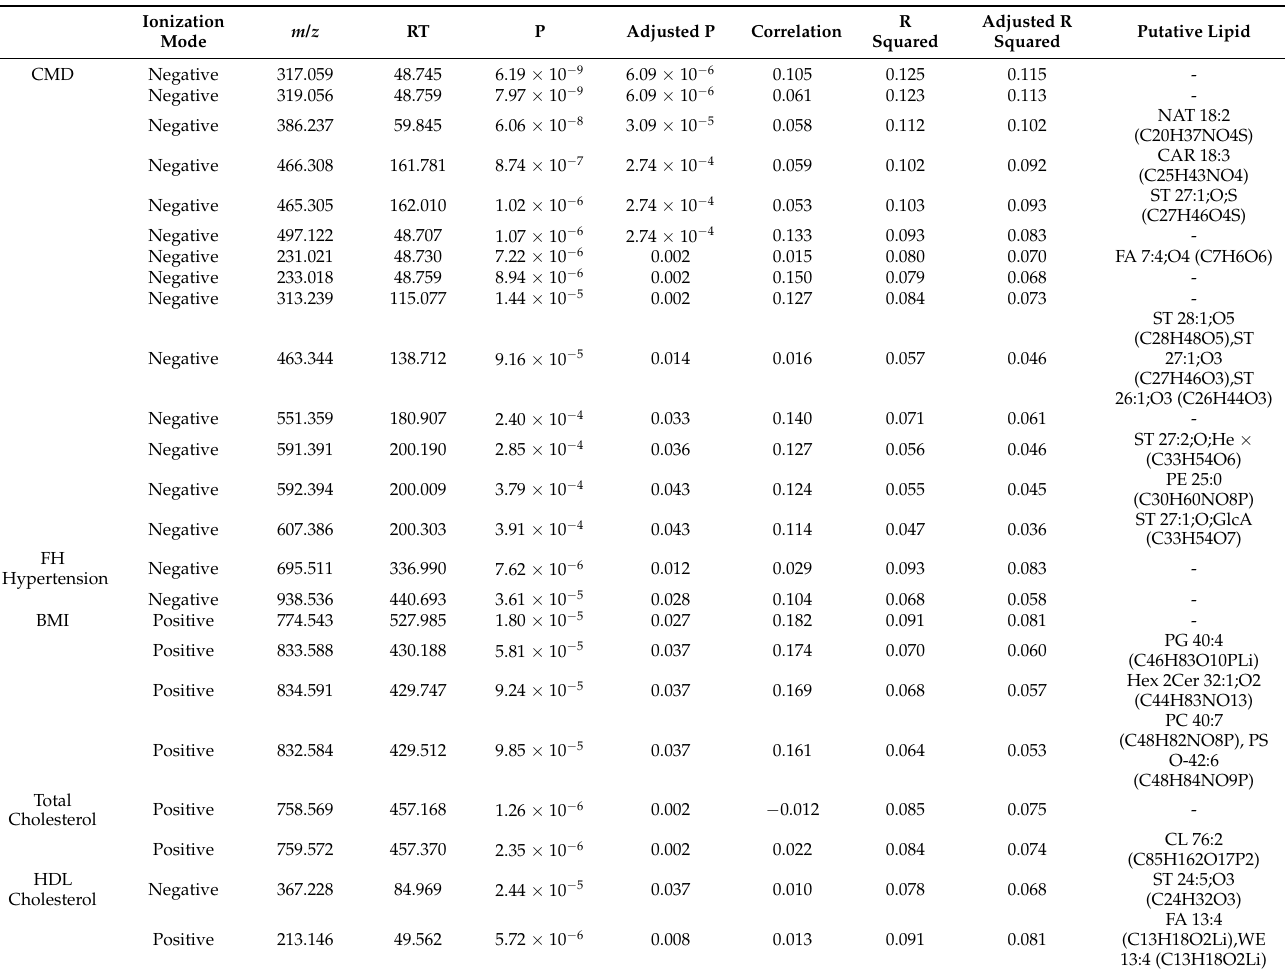
Table 4. Significant associations between lipidomic features and clinical and biochemical phenotypes in the study group. Lipidomic features were independently acquired in negative- and positive- ionization modes in serum samples from a study group of 273 individuals. Linear regression was used to compute a P-value statistic for each metabolic feature, which was corrected for multiple testing using the Benjamini-Hochberg method to calculate adjusted p -values. Significant evidence of association was obtained for cardiometabolic disease (CMD), family history (FH) of hypertension, body-mass index (BMI) and total and HDL cholesterol. CMD was assessed by presence of at least three anomalies (diabetes, hypertension, BMI > 30kg/m 2 , HDL < 40mg/dl). Results from association analysis for all phenotypes that did not reach statistical significance following correction for multiple testing (nominal p -value < 0.05) are shown in Supplementary Table S3. Mass-to-charge ratio ( m / z ) and retention time (RT) are reported for each lipidome feature. Assignment of lipid candidates for lipidome features was performed using LIPID MAPS